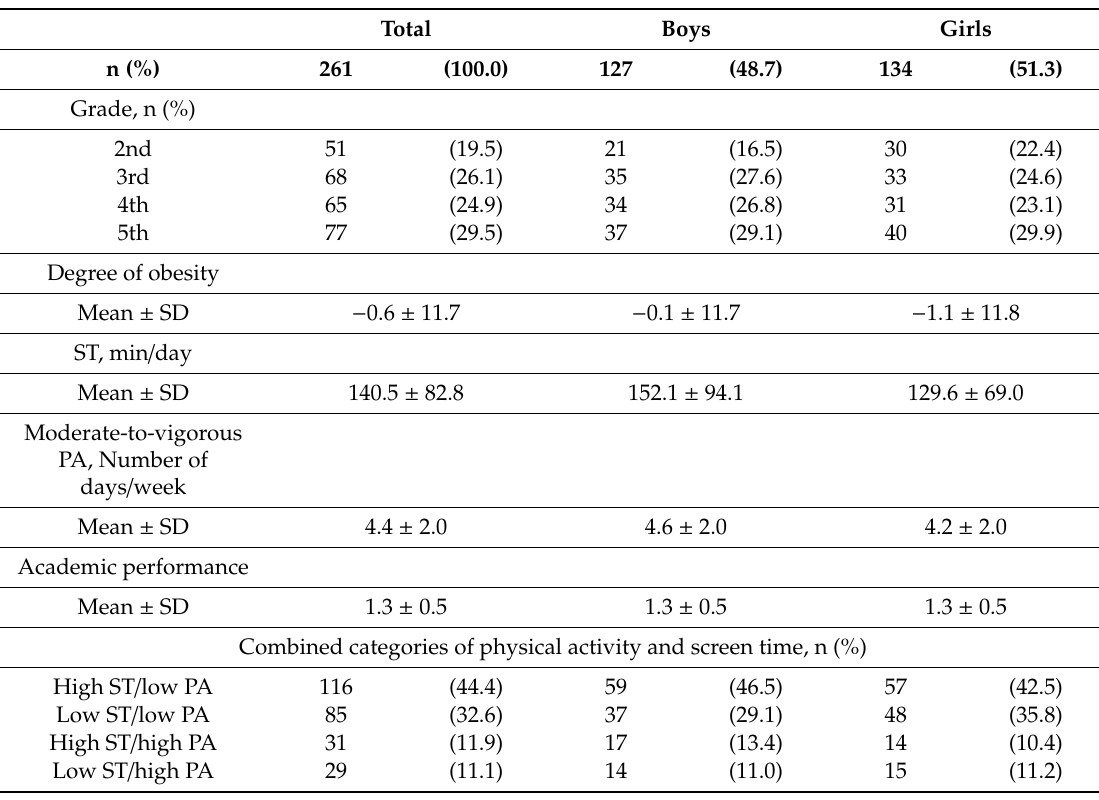
Table 1. Descriptive characteristics, physical activity data, and academic psychological performance stratified by